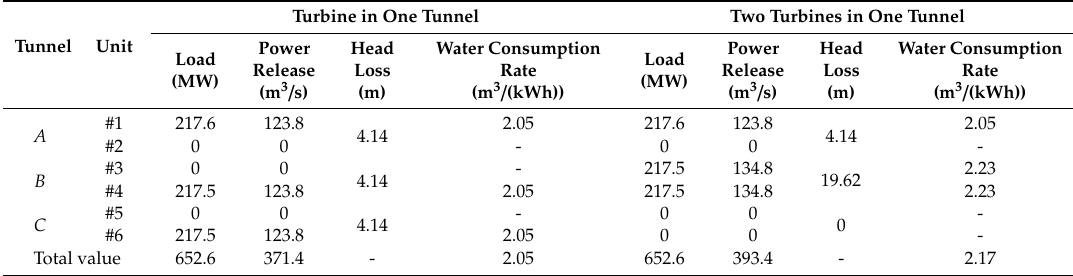
Table 3. Comparison of a turbine in one tunnel and two turbines in one tunnel.